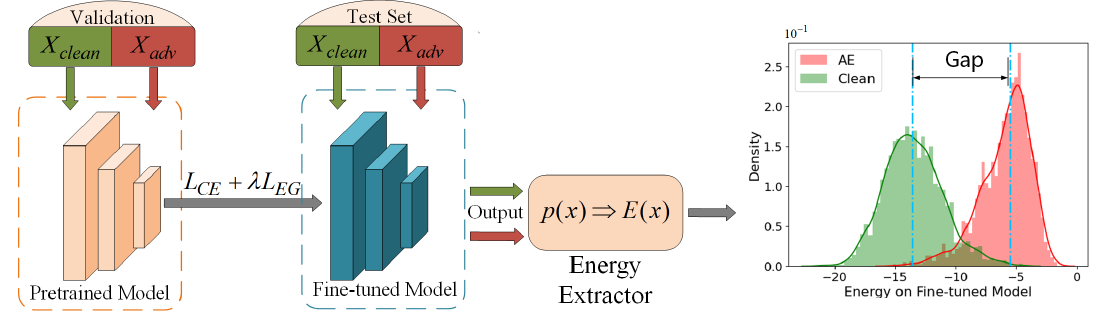
Figure 4. Framework of energy-based detection on a fine-tuned model. The energy map is generated by the same samples in Figure